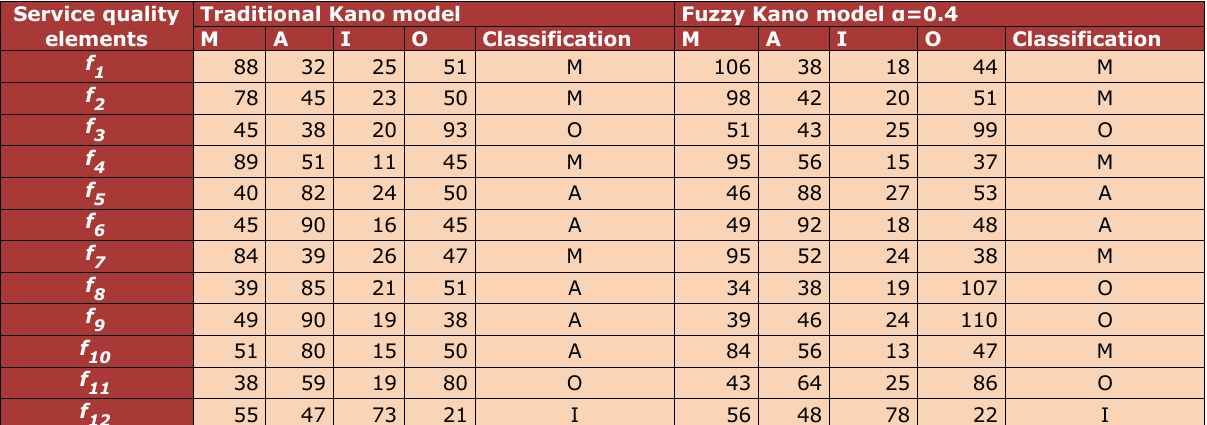
Table 9. Comparison of classification results of service quality